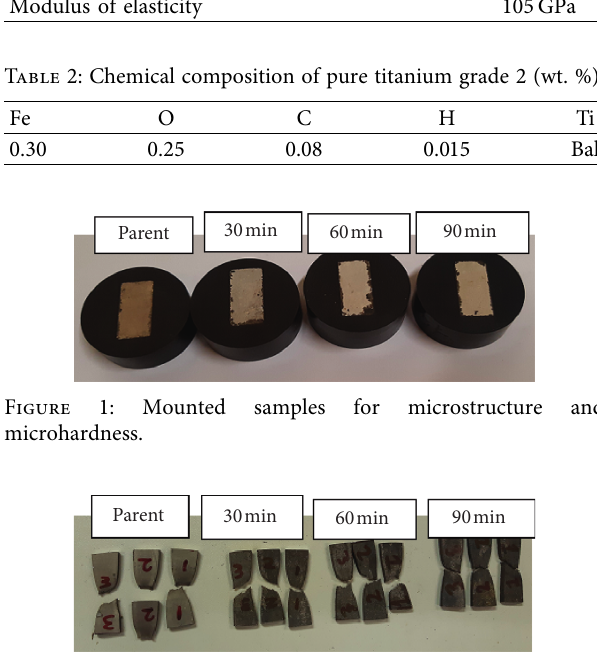
Figure 2: Prepared SEM